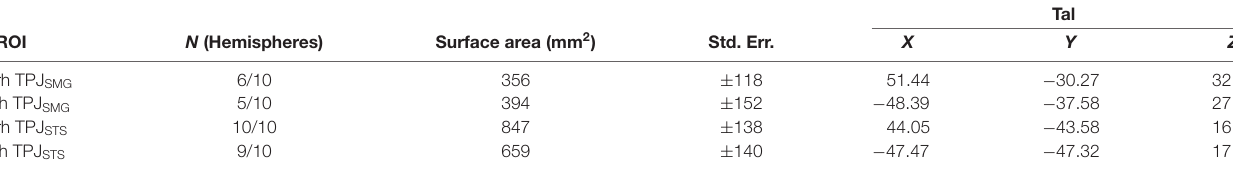
TABLE 2 | Vivid, Novel Oddball-localized TPJ areas in individual